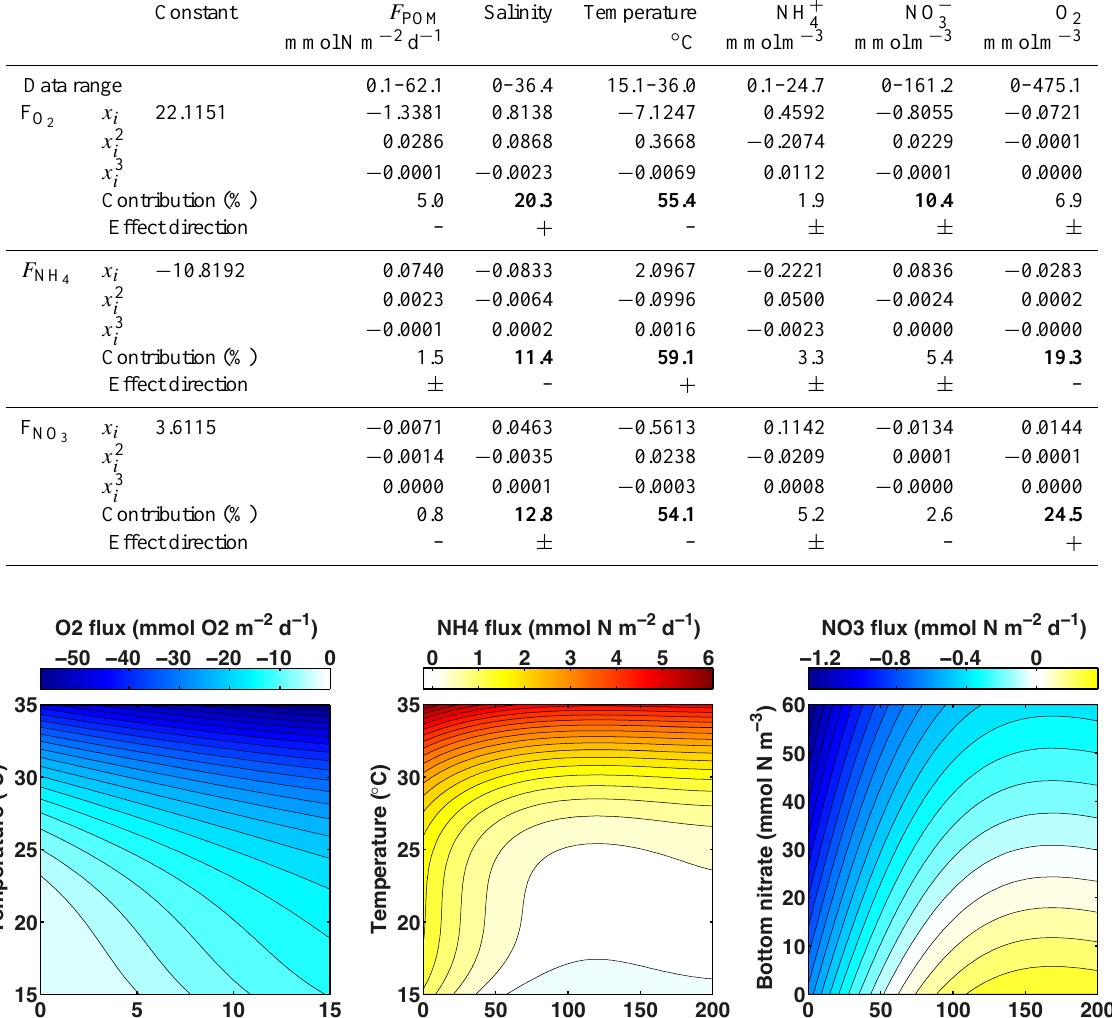
and NO − fluxes. Negative fluxes (blue shades) are into the sediment and positive 4 3